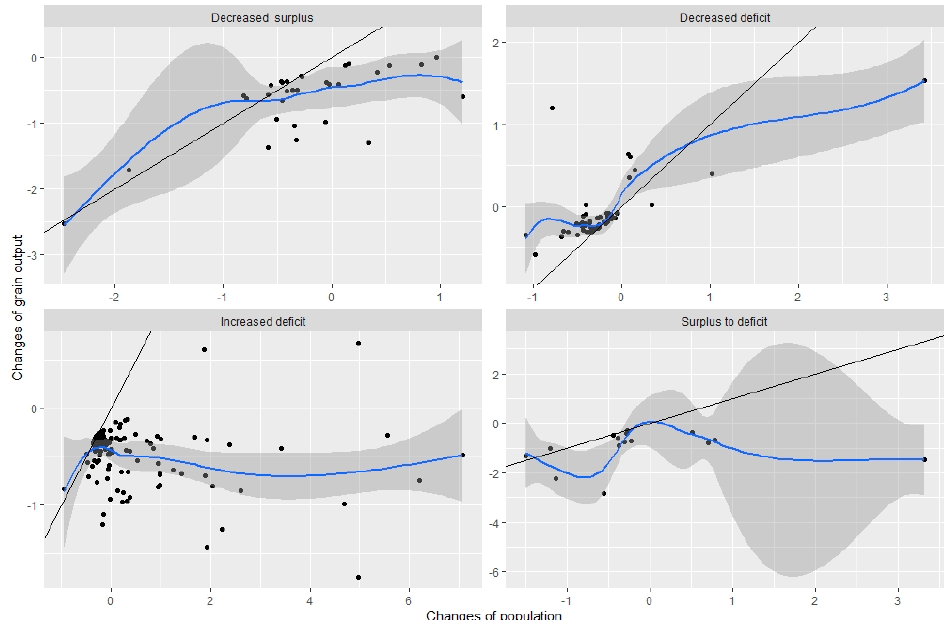
Figure 4. Normalized variations in the population and the grain output for four types of grain insecurity. The horizontal axis indicates the normalized variation of the population, and the vertical axis indicates the grain output. A positive value indicates that the change is above the mean and a negative value indicates that it is below the mean; the black points denote 220 cities in China. The solid black line is the linear equation (y = x). If points are above the 1:1 fit line, the changes in the grain output are more significant than those in the population, and vice versa.